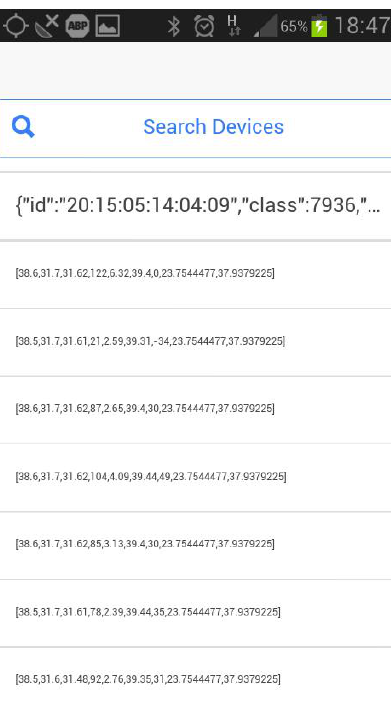
Figure 5. Data Acquisition on the Android application; Presented values within each line are: Relative Humidity, Temperature, Heat Index, Luminosity, CH4 ppm, CO ppm, dB, longitude,